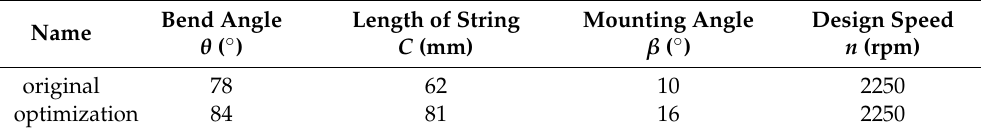
Table 2. A comparison between prototype and optimization